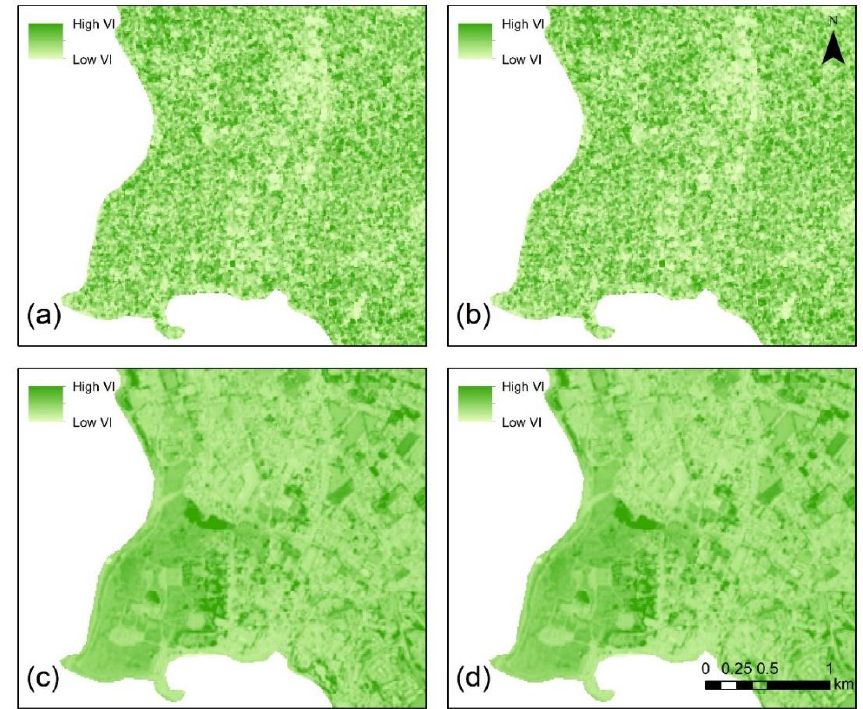
Figure 8. The proportion of vegetation cover based on the RVI using Equation (3) ( a ) and Equation (5) ( b ), and the NDVI based on Equation (4) ( c ) and Equation (6) ( d ).